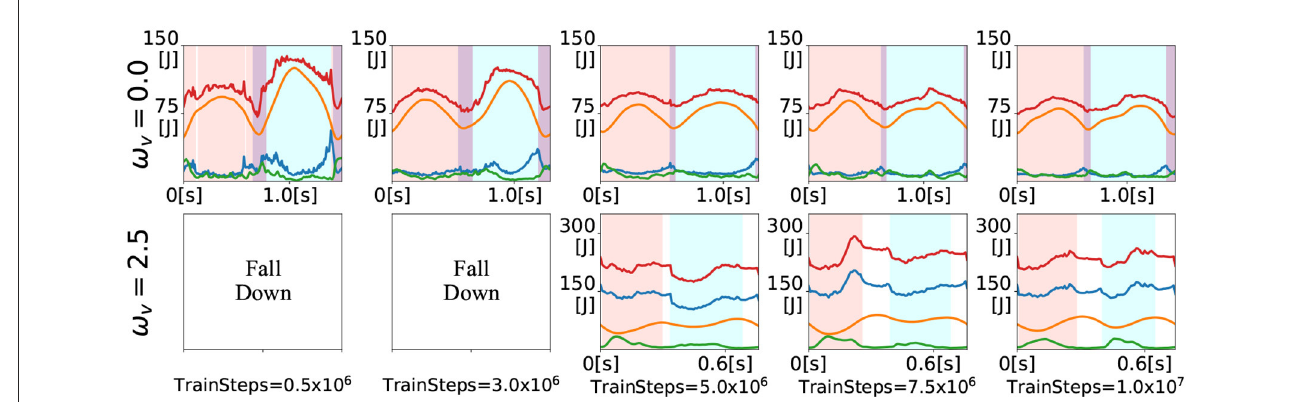
0 and ω v 2.5 during training. The colored lines denote the kinematic (blue), potential (orange), elastic = =